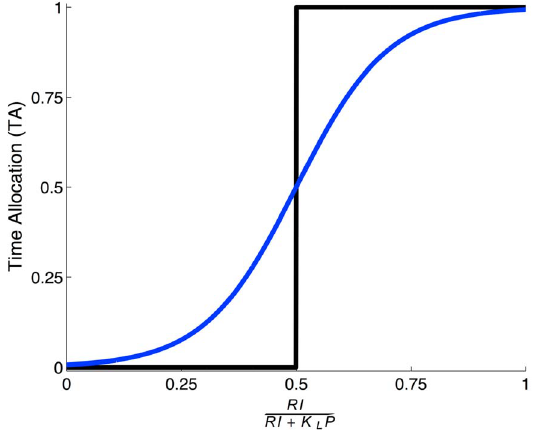
Figure 2. Time allocation from labor supply theory. TA as a function of the relative returns from work and leisure predicted by labor supply theory model in Eq. (1). Black and blue curves show the cases of perfect ( s ~ 1 ) and imperfect substitutability ( s v 1 ),